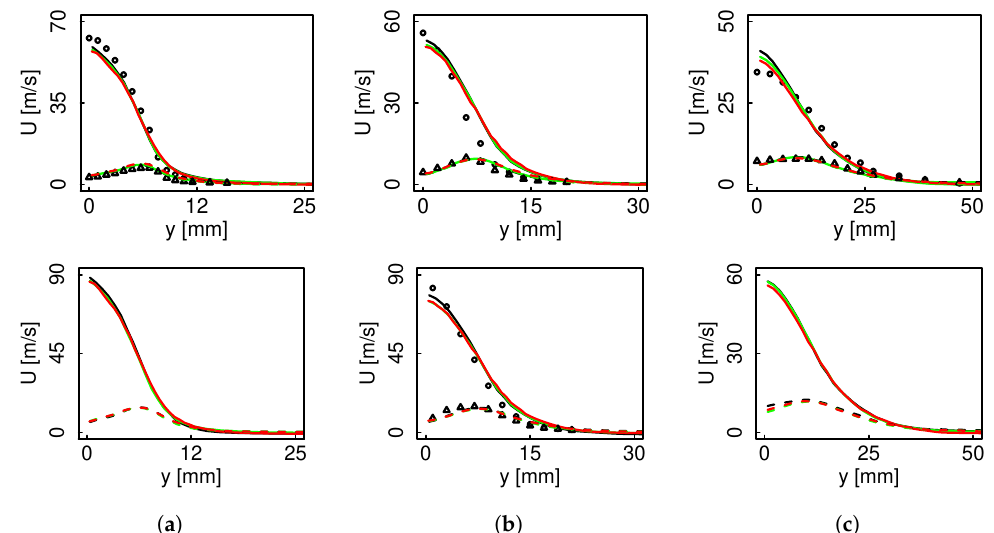
Figure 7. Velocity mean and RMS radial profiles for flame D ( top ) and E ( bottom ). Black color represents non-premixed FTACLES, green color premixed FTACLES, red color FPV, solid line mean, dashed line RMS. Circles depict experimental mean, and triangles experimental RMS. ( a ) x / d = 7.5; ( b ) x / d = 15; ( c ) x / d =